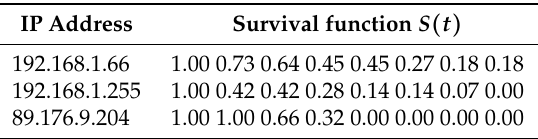
Table 1. Gene expression